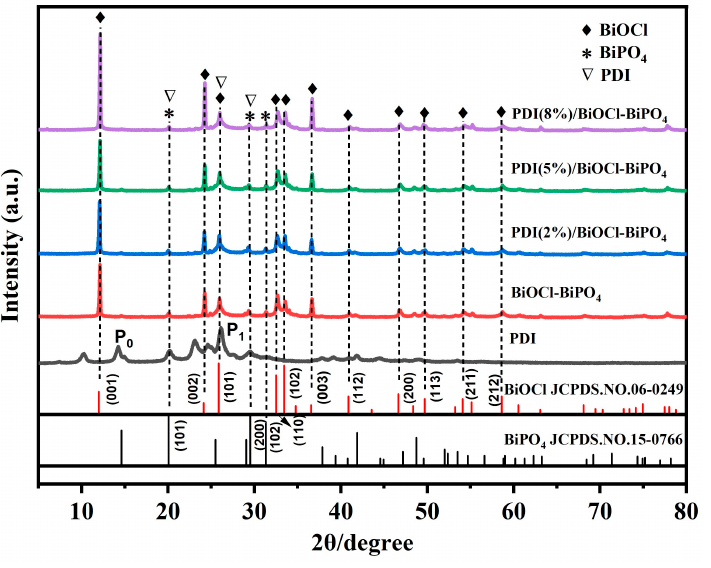
Figure 1. The XRD patterns of PDI, BiOCl-BiPO 4 , PDI(2%)/BiOCl-BiPO 4 , PDI(5%)/BiOCl-BiPO 4 and PDI(8%)/BiOCl-BiPO 4 samples.